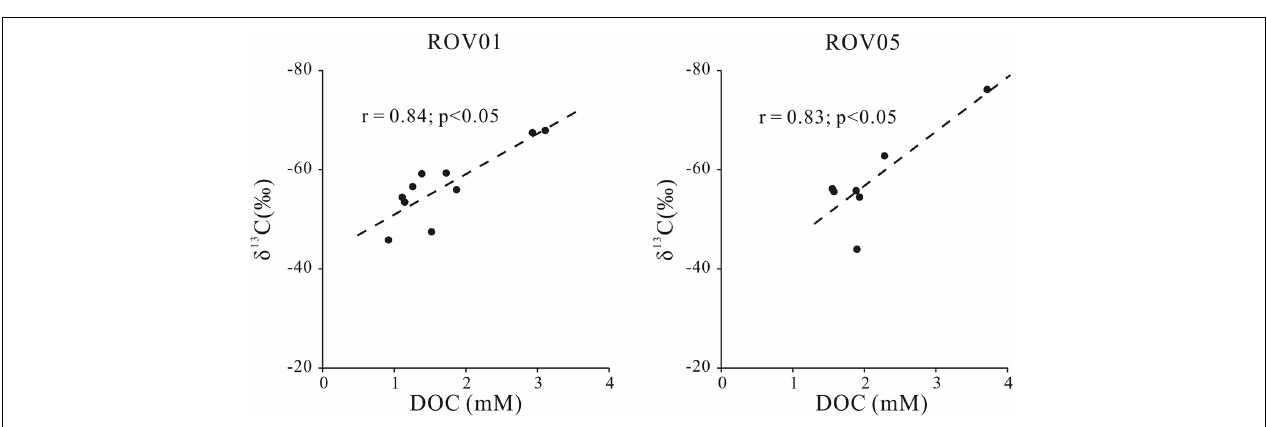
FIGURE 5 | Cross-plot of concentrations and δ 13 C of DOC at seeps sites (ROV1 and